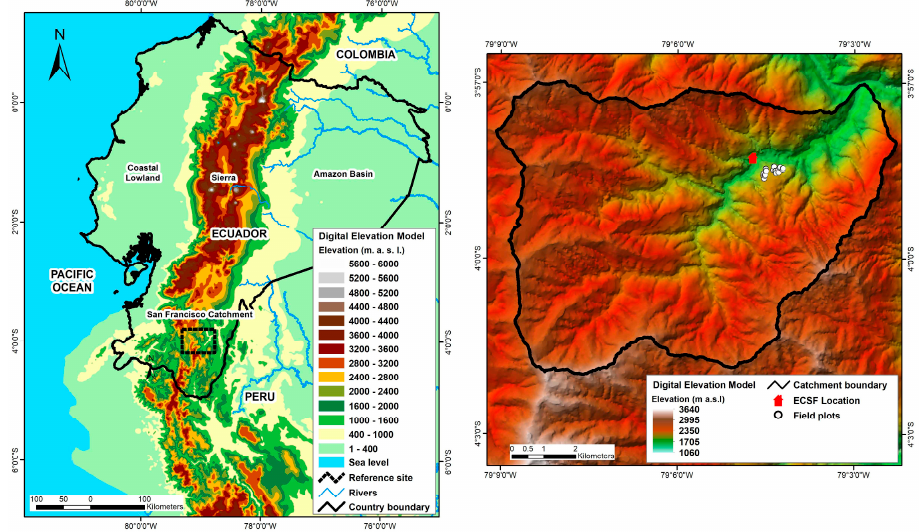
Figure 1. Digital Elevation Model (DEM) of the study area, the San Francisco catchment, including the field plot distribution.